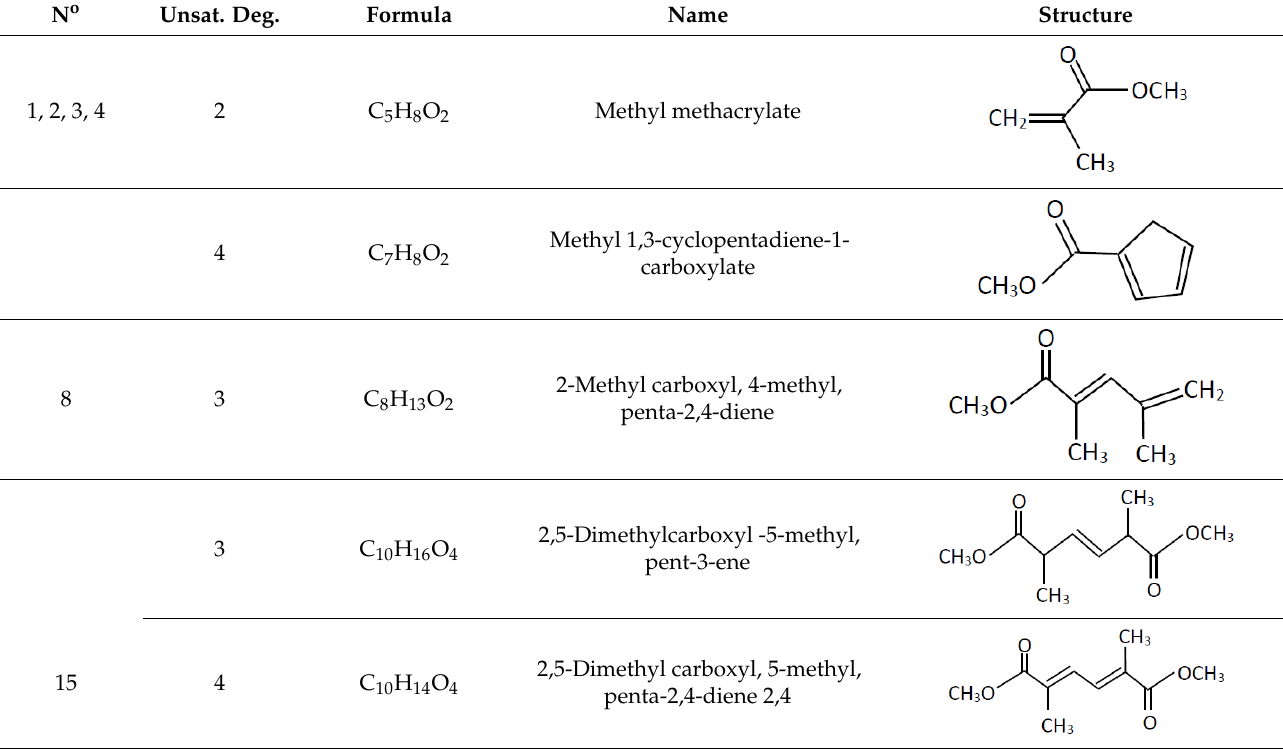
Table 3. The main probable molecules or their isomers resulting from the decomposition of PMMA. N o Unsat. Deg.